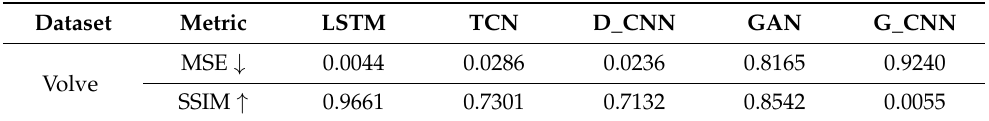
Table 2. Results of the experiments on the Volve dataset with the five neural network models. The metrics were obtained by comparing the test data and the result generated by each network. The symbol ↓ indicates that the smaller the value, the better the result, while ↑ indicates that the bigger the value, the better the